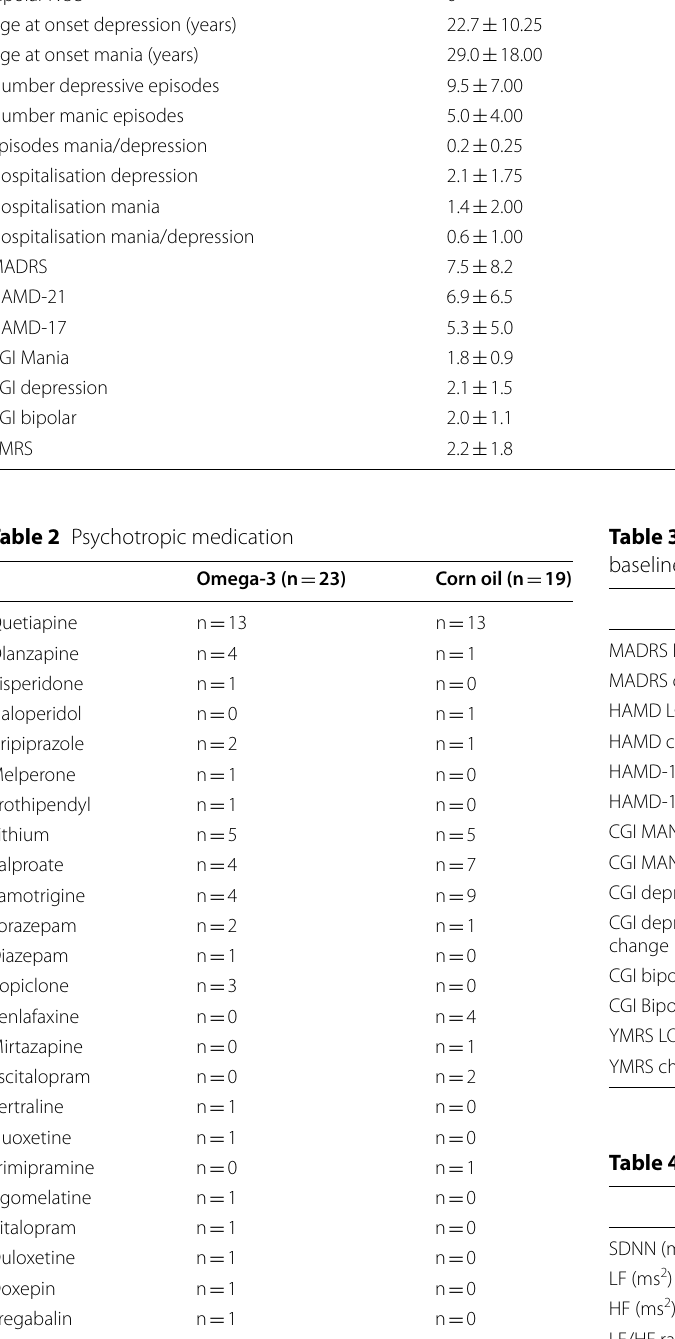
sd [missing values] ±